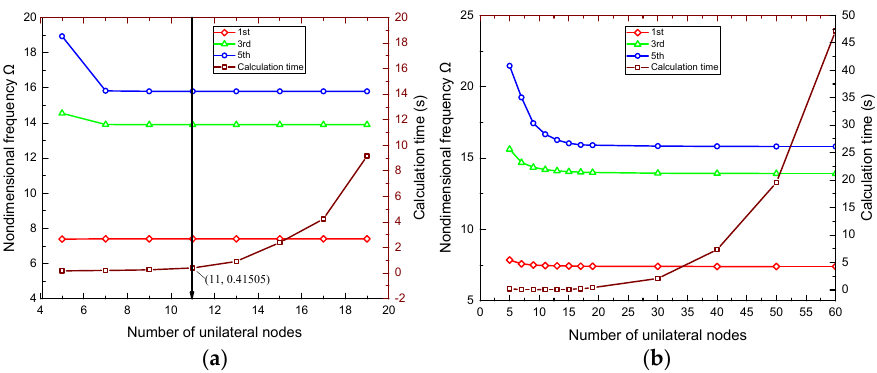
Figure 10. Variations of nondimensional frequencies and the corresponding calculation time vs. the number of unilateral nodes for CCCC laminates with h / b = 0.1: ( a ) the present method; ( b ) FEM using Q4 element.